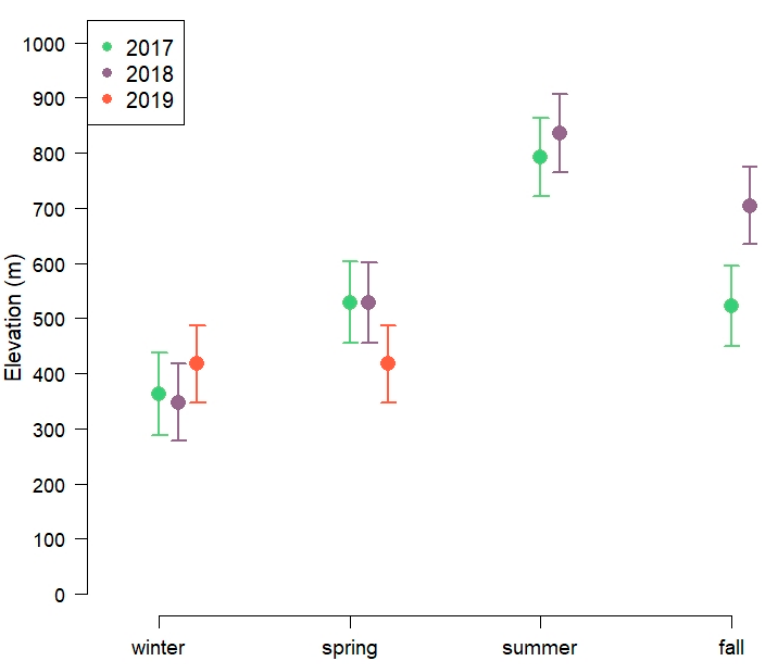
Figure 2. Elevational position of spatial clusters during different seasons and years of 13 GPS-marked red deer in Lærdal municipality, Norway. Animals 2021 , 11 , x FOR PEER REVIEW Agricultural fields . Overall, 16.7% of clusters were in agricultural fields ( n = 39,334), and for the winter season, 39%. The probability of clusters being in agricultural fields var- ied depending on the interaction between season and year (Figure 3, Tables S1 and S2). There was low probability of clusters being on agricultural fields during summer in both 2018 and 2019. The probability of clusters being on agricultural fields during the winter varied strongly depending on year, from around 0.5 in 2017 to 0.15 in 2019 with 2018 being intermediate. Spring and fall months had intermediate probability of being on agricultural fields. The probability of the clusters being in agricultural fields decreased with an in- creasing amount of snow (Table S4).